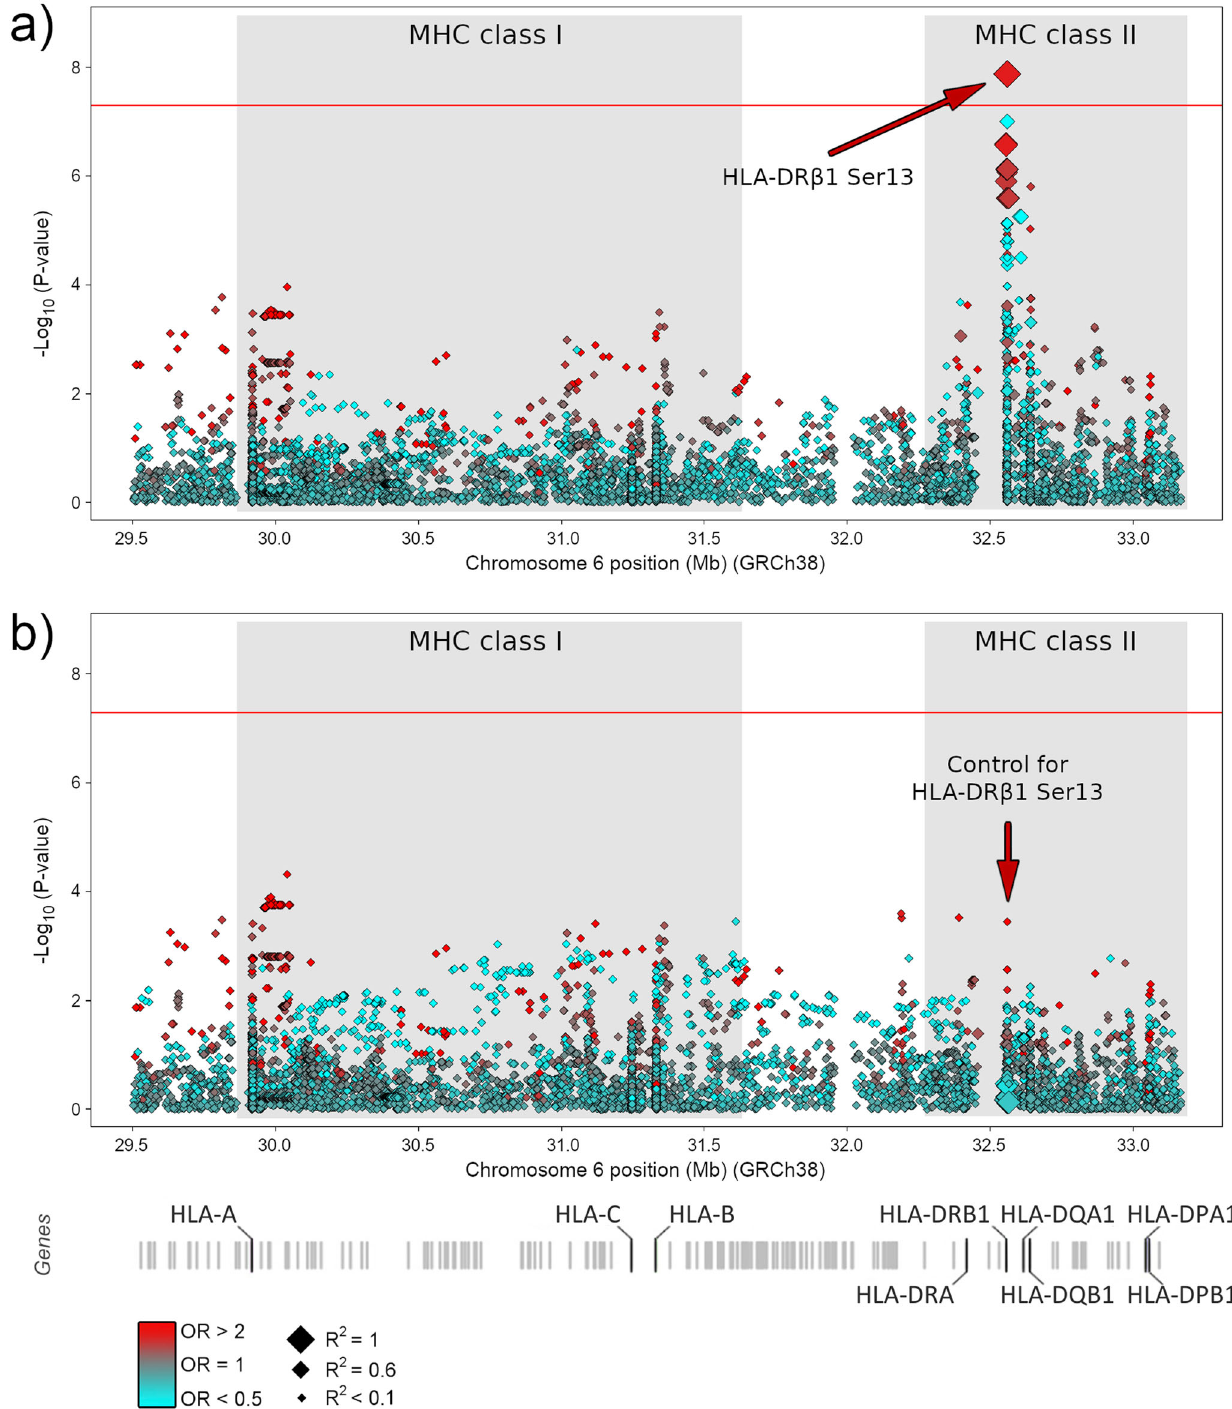
Fig. 2 Manhattan plot representation of the logistic regression test of the MHC region accordingly with Sertoli cell-only phenotype. a Unconditioned test of the MHC region. b Results of the MHC region after conditioning on HLA-DR β 1 Ser13. The − log10 of the combined logistic regression test P -values are plotted against their physical chromosomal position. A red/blue colour gradient was used to represent the effect size of each analysed variant (red for risk and blue for protection). The red line represents the genome-wide level of signi fi cance ( P < E −